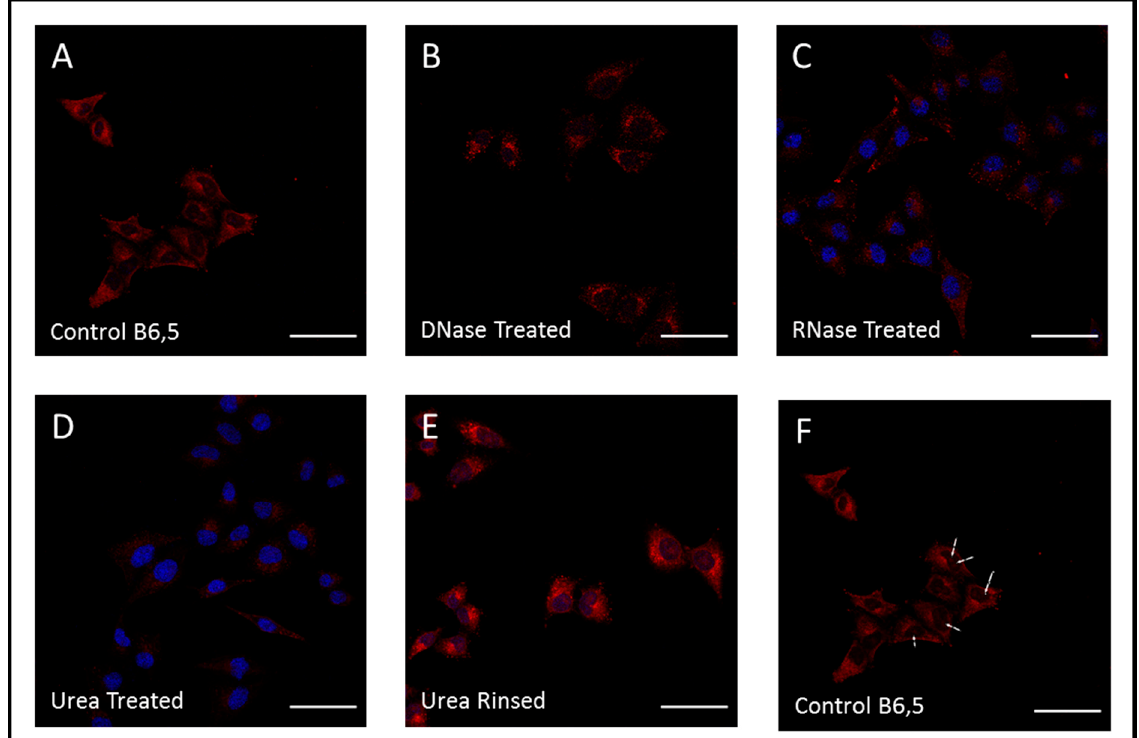
Figure 7. Confocal laser scanning microscope (CSLM) imaging of fixed HeLa cells with ( A ) B6,5, ( B ) DNase, ( C ) RNase, ( D ) Urea treated, ( E ) Urea rinsed with PBS (pH 7.4), and ( F ) B6,5 stained cells without DAPI channel overlay. The nucleus is co-stained using DAPI. Scale bar 50 µm. For clarity images are presented in pseudo colors of red for B6,5 and blue for DAPI.